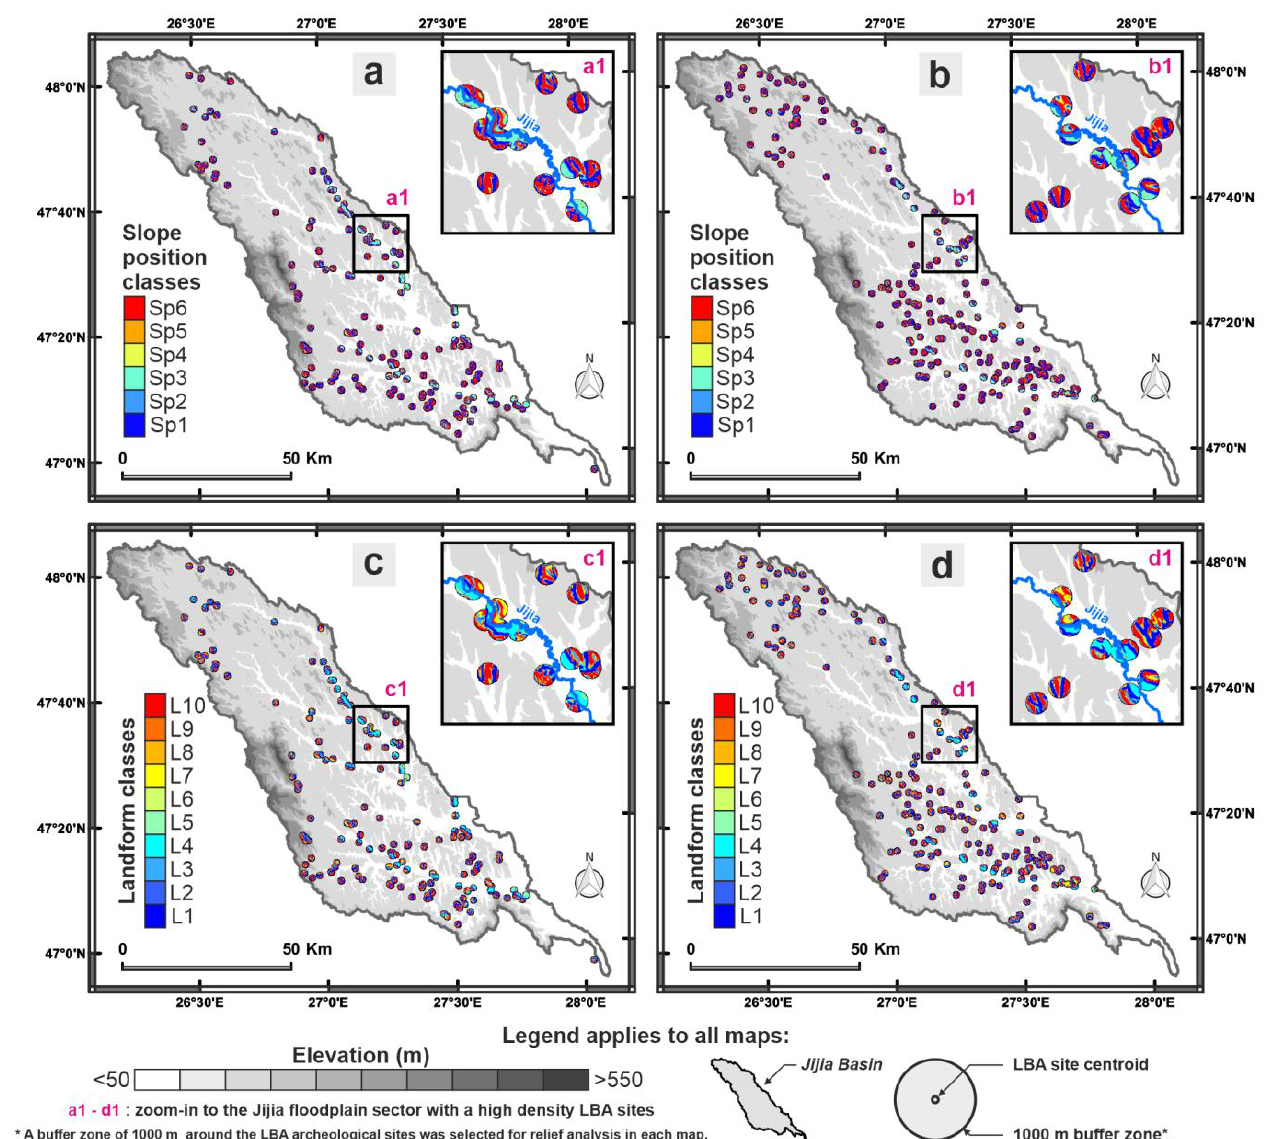
Figure 7. Automated relief analysis of LBA sites in the Jijia catchment: slope position classification based on TPI-derived DEV with six morphological classes (see Table 1) of the ( a ) LBA archaeological sites without ashmounds (167 sites) and ( b ) LBA sites with ashmounds (195 sites); landform classification based on TPI-derived DEV with ten landform types (see Table 2) of the ( c ) LBA archaeological sites without ashmounds (167 sites) and ( d ) LBA sites with ashmounds (195 sites). Last but not least, we have to take into consideration some of the archaeological excavations performed on settlements with no ashmounds visible on the surface, located